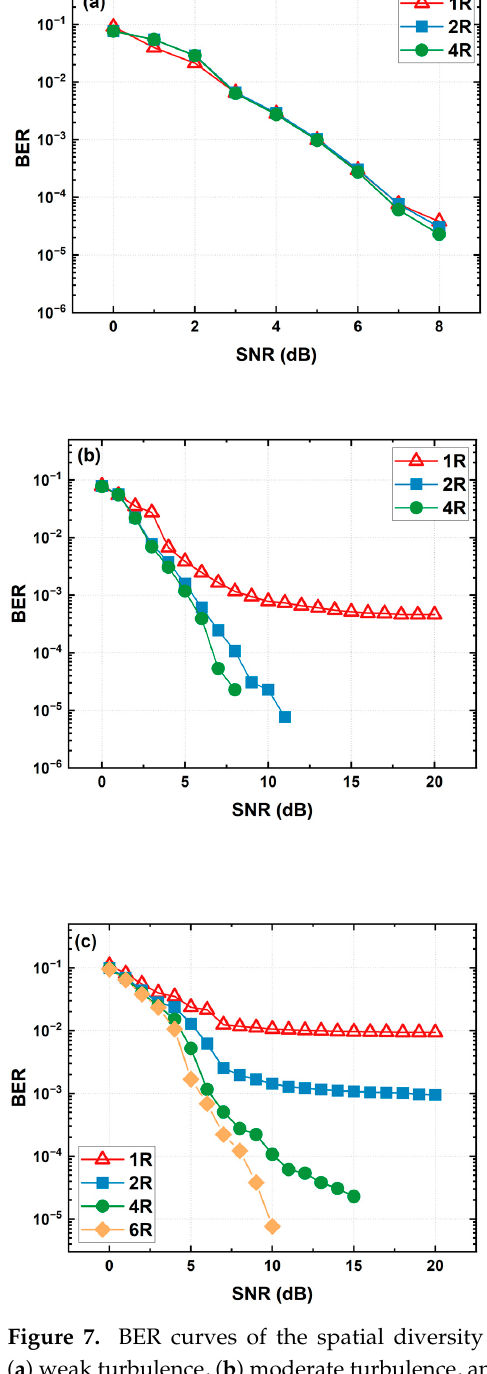
Figure 7. BER curves of the spatial diversity reception under different turbulence conditions: ( a ) weak turbulence, ( b ) moderate turbulence, and ( c ) strong turbulence.